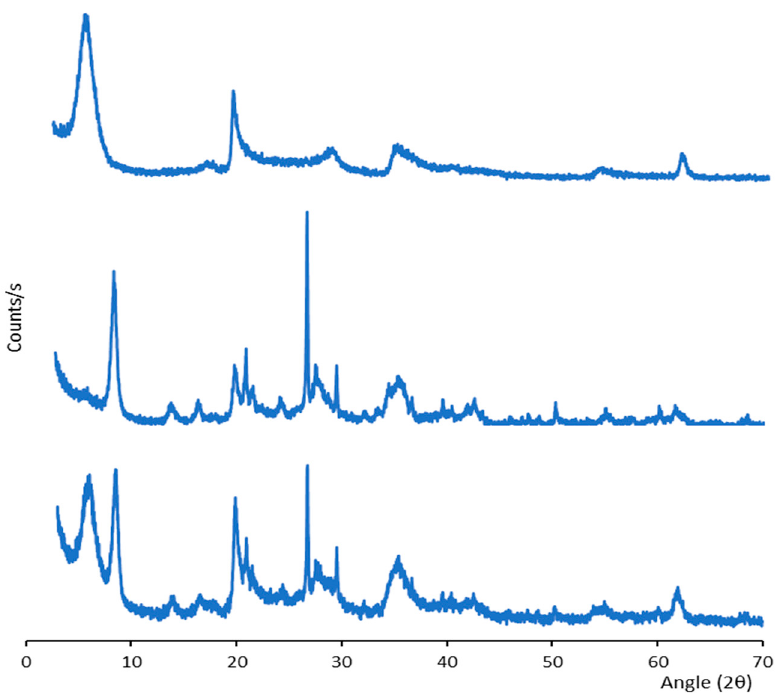
Figure 4. XRPD diffraction patterns of B-CUR (top panel), P-CUR (middle panel), and B/P-CUR (bottom panel) hydrogels.